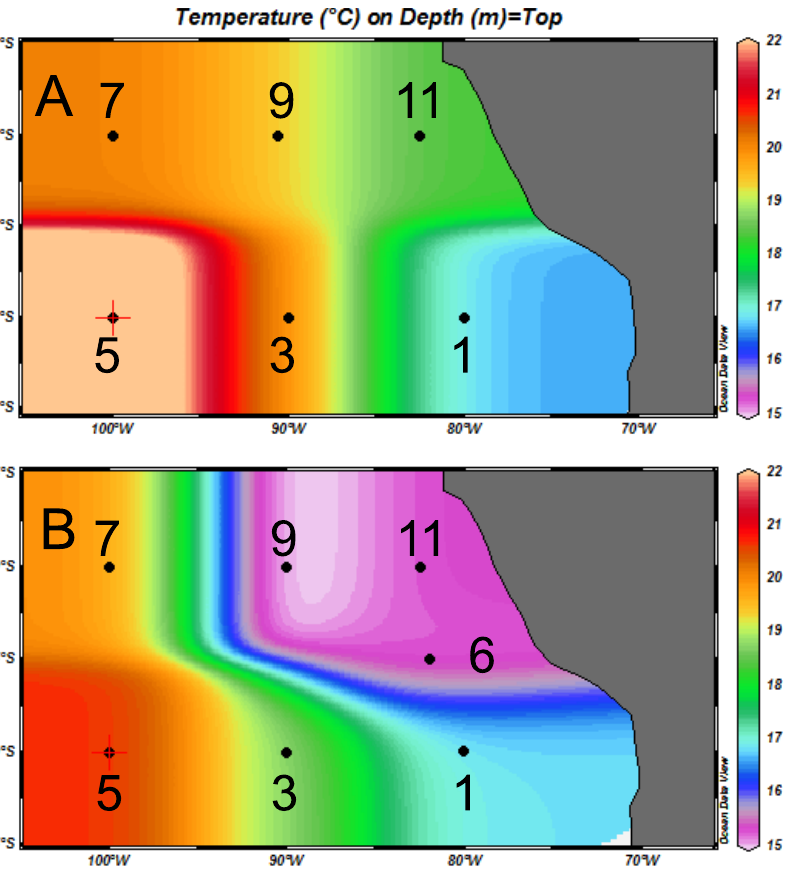
Figure 1. Location of stations superimposed upon seawater temperature at 75-m-depth. (A) the 2010 cruise (R/V Atlantis), and (B) the 2011 cruise (R/V Melville). Station numbering are identical to that of 2 companion papers [28,42]).